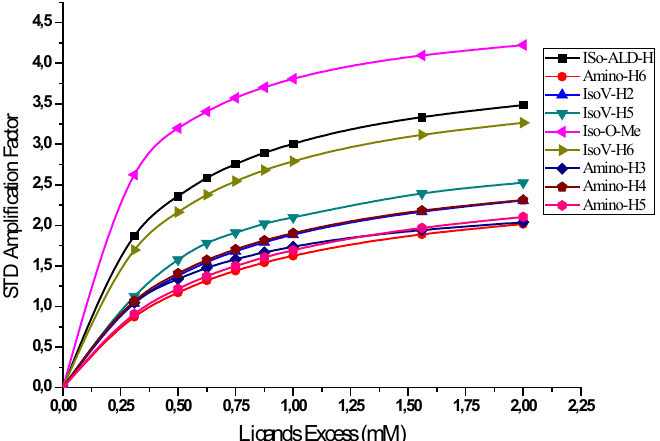
Figure 5. STD ampli fication factor curve plot of 2-aminopyridine and Isovanillin as a function of varying concentrations ranging from 0.25 mM to 2.00 mM for each single parabolic line that determined from the STD titration spectra as shown in ESI†.